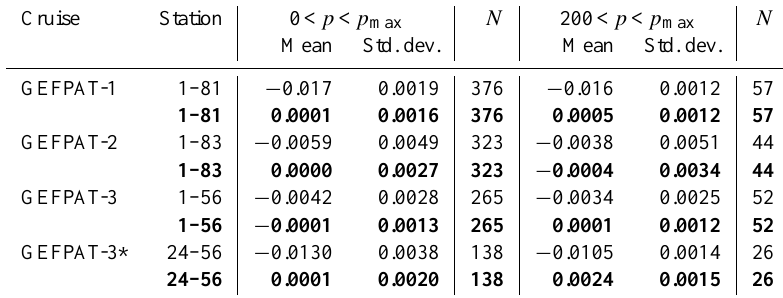
Table 2. Comparison of CTD vs. water sample salinity. Pre- and post-calibration (bold) for each cruise calculated for the whole water column (0 <p <p max ) and below 200dbar (200 <p <p max ). Number of samples ( N ) is indicated for each set. Cruise Station 0< p < p max N 200< p < p max N Mean Std. dev. Mean Std. dev.